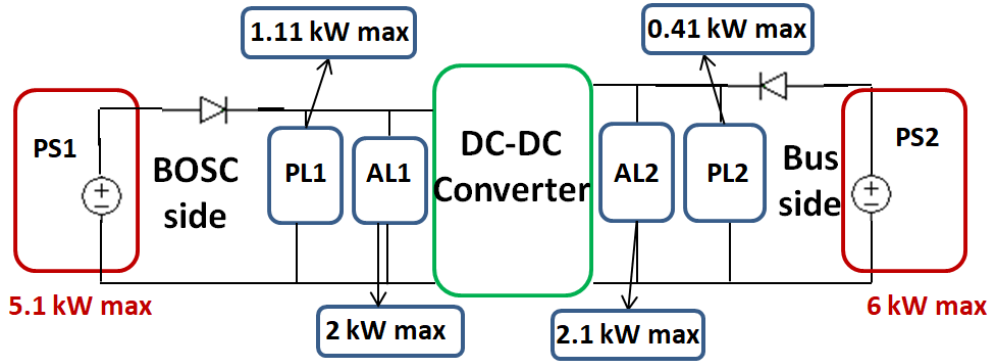
Figure 12. Schematic of the test setup.